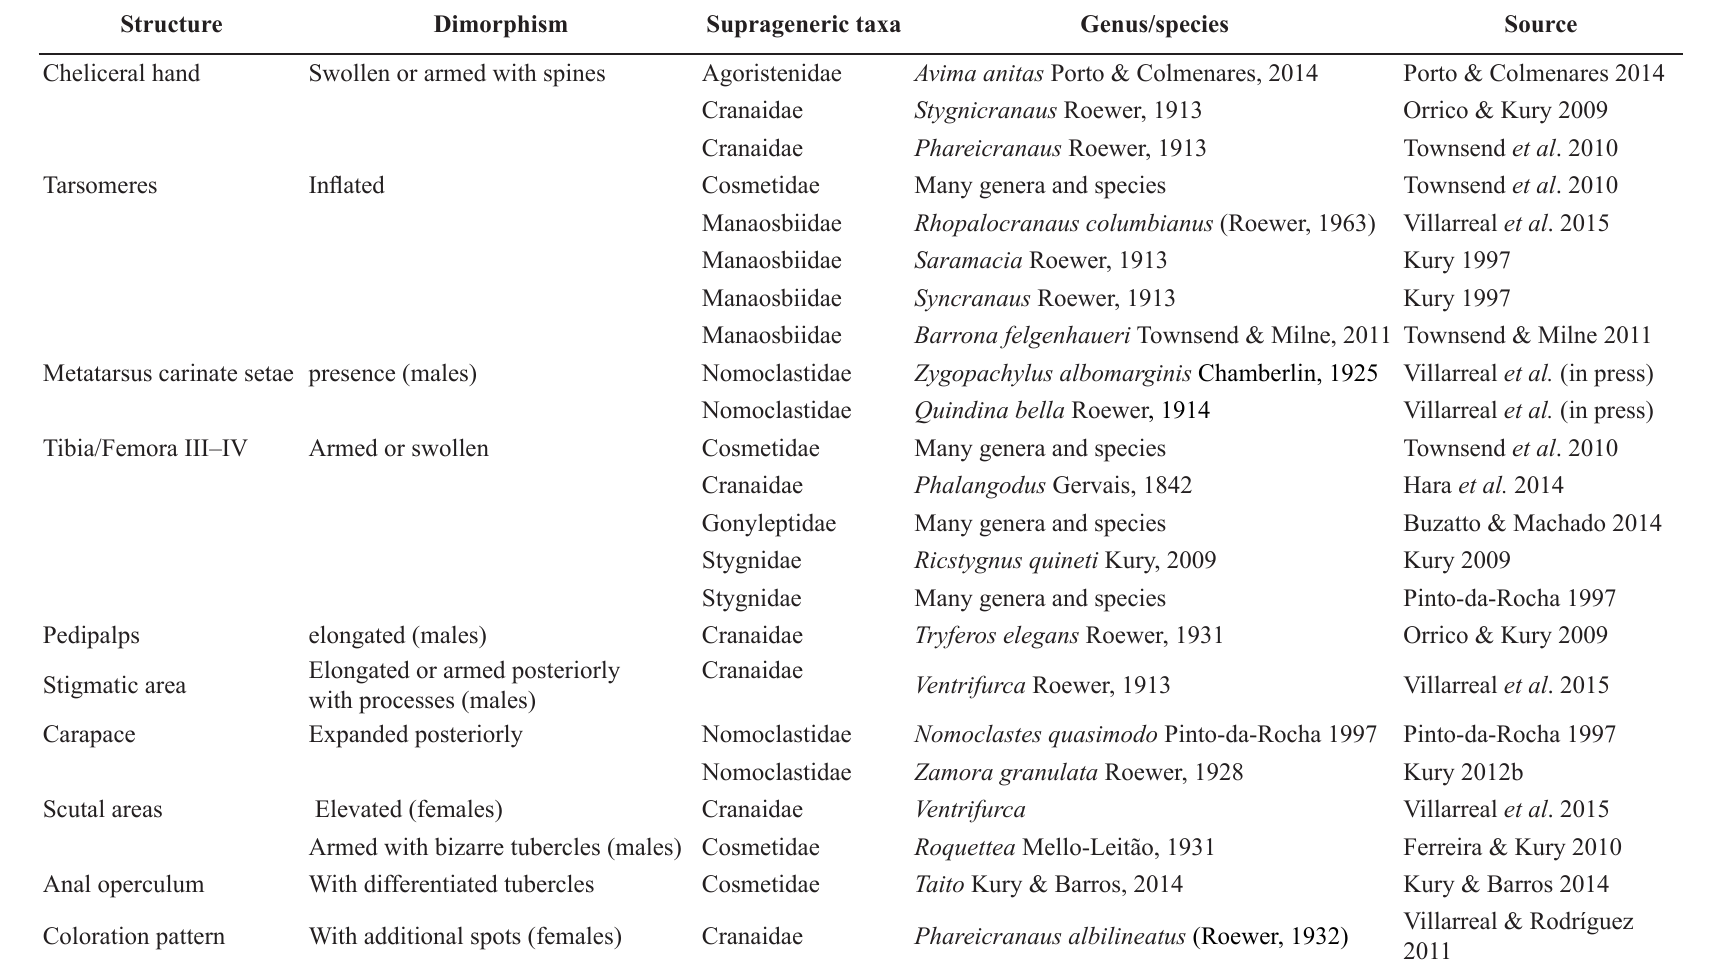
Table 9. Some examples of sexual dimorphism in